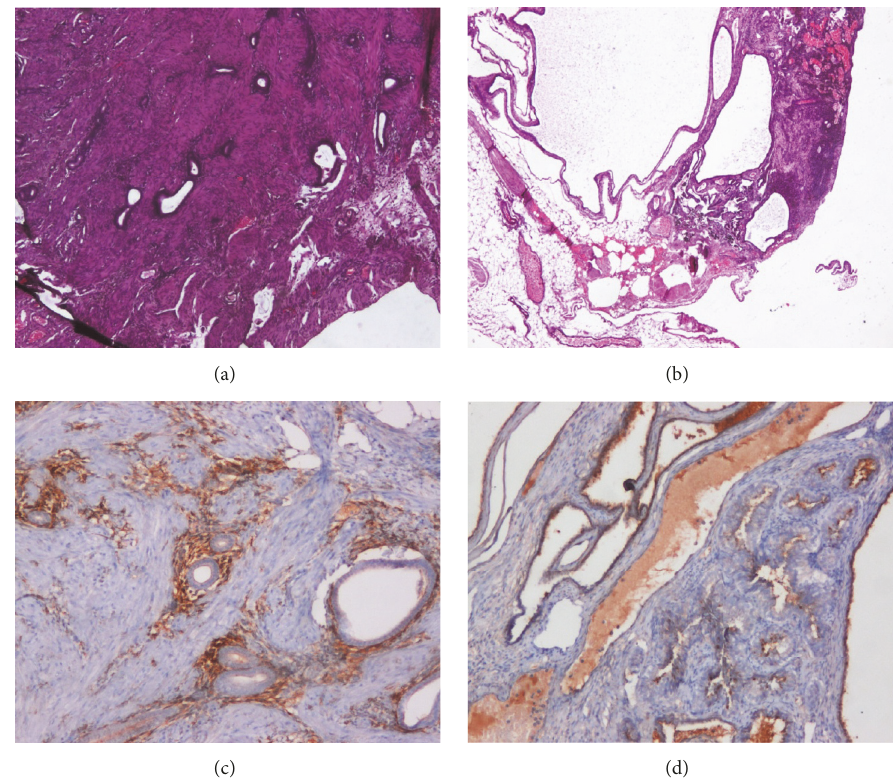
Figure 1: (a) Presence of ectopic endometrium in the uterine wall (H&E, original magnification × 10). (b) Cystic endometriosis present in the ovary (H&E, original magnification × 10). (c) The adenomyosis in the uterine wall is surrounded by a stromal reaction evidenced by the CD10 positivity (ABC, original magnification × 10). (d) The ectopic glandular epithelium of the cystic structure in the ovary expresses estrogen, as evidenced by immunohistochemistry with a monoclonal antibody specific for estrogen (ABC, original magnification ×